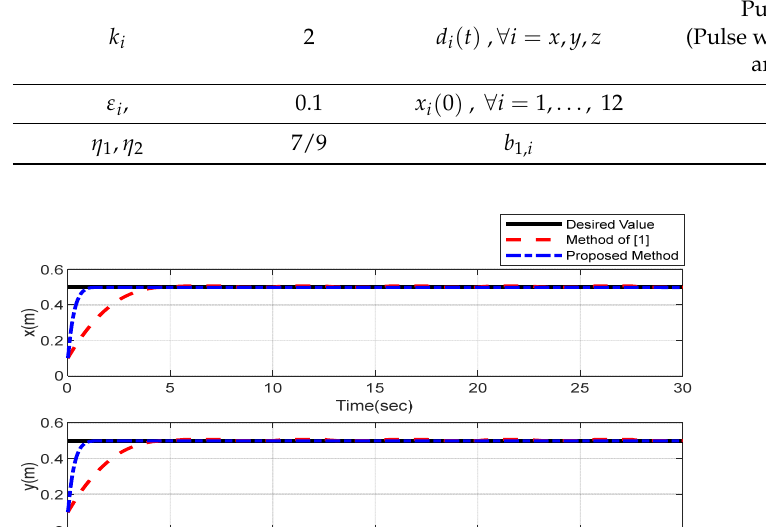
Table 2. Parameters of the quadrotor’s system [33] .